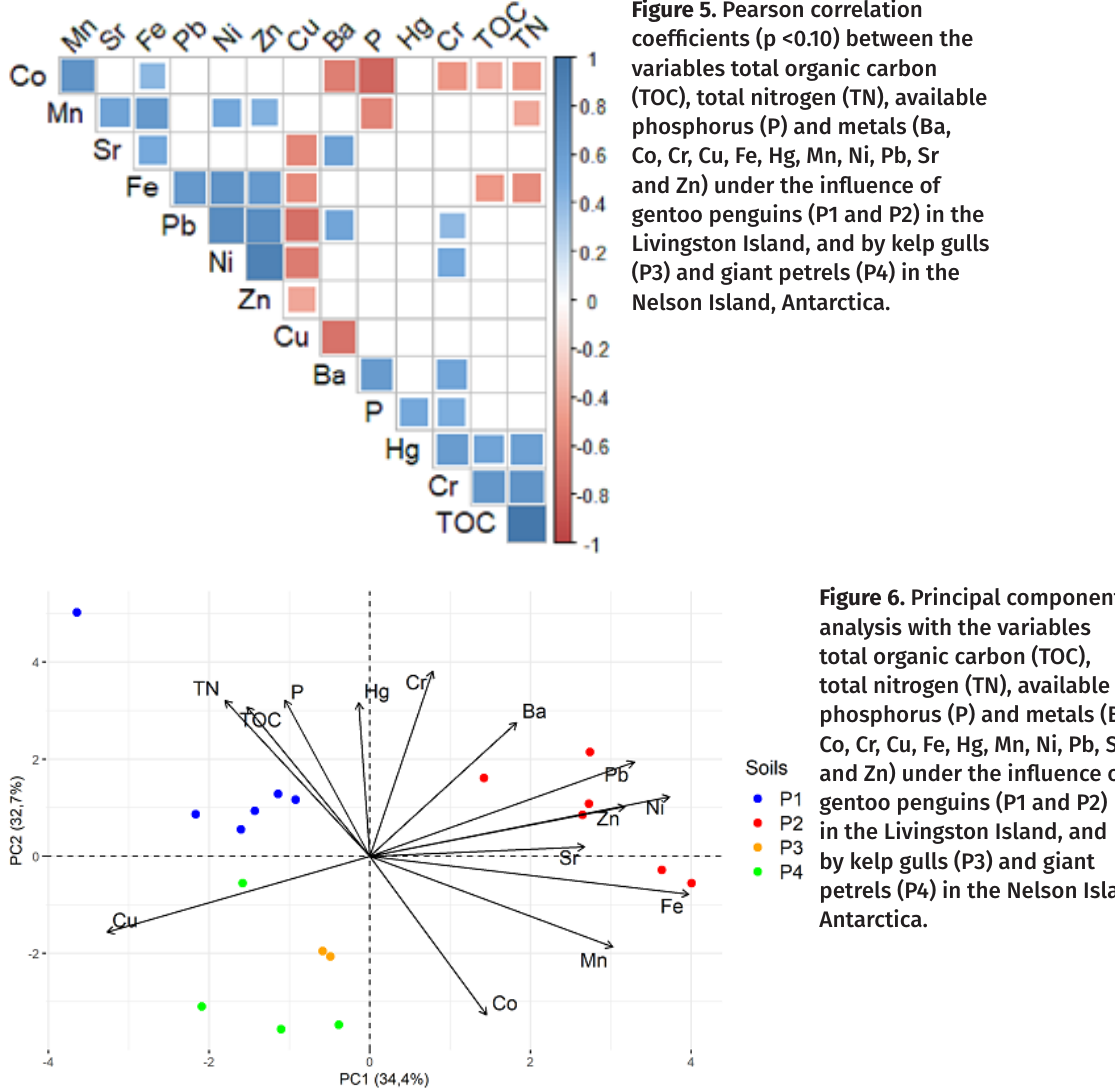
Figure 5. Pearson correlation coefficients (p <0.10) between the variables total organic carbon (TOC), total nitrogen (TN), available phosphorus (P) and metals (Ba, Co, Cr, Cu, Fe, Hg, Mn, Ni, Pb, Sr and Zn) under the influence of gentoo penguins (P1 and P2) in the Livingston Island, and by kelp gulls (P3) and giant petrels (P4) in the Nelson Island,